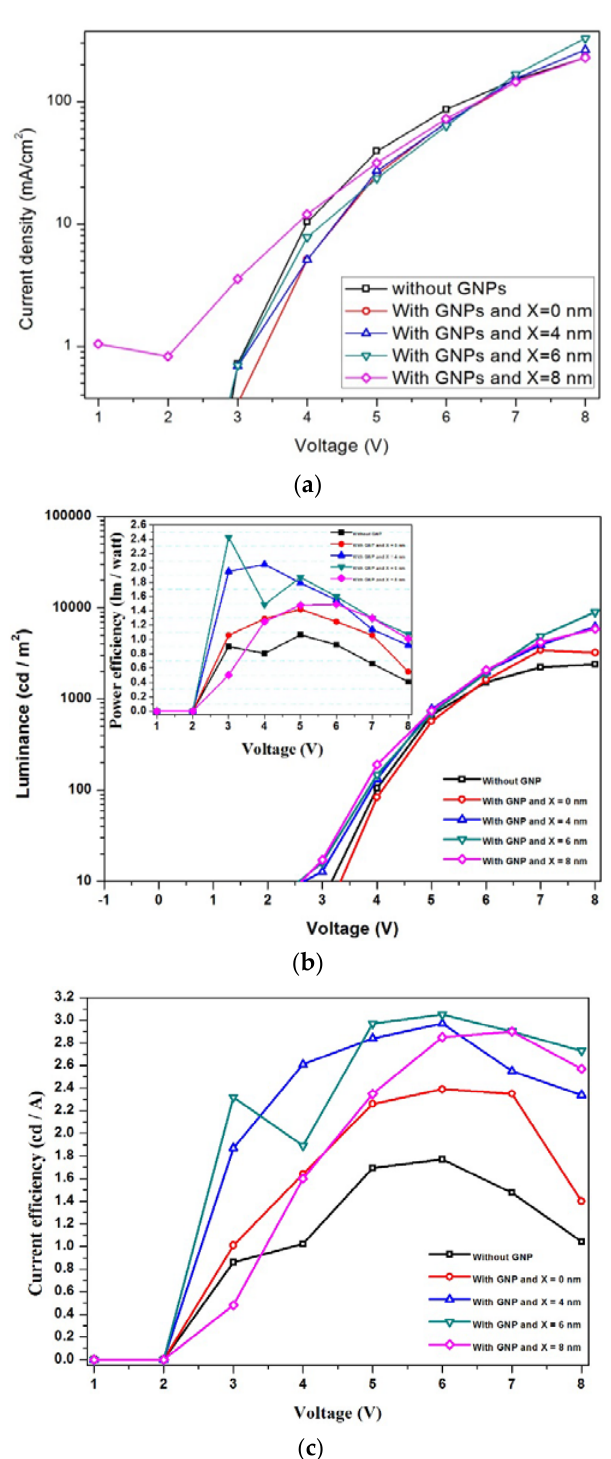
Figure 3. ( a ) Current density-voltage curves; ( b ) luminance-voltage curves in log scale; and ( c ) current efficiencies curves of devices without GNPs and with different spacing distances. Inset of ( b ) shows the power efficiency-voltage characteristics of device.